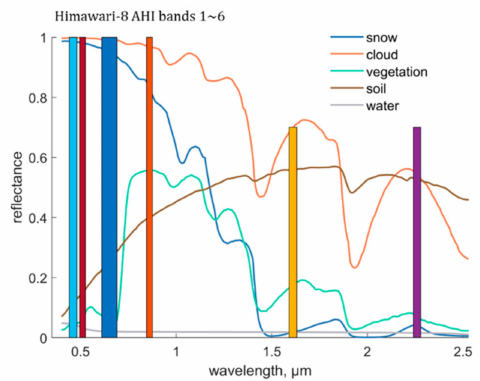
Figure 3. Reflectance of snow, water cloud, vegetation, soil, and